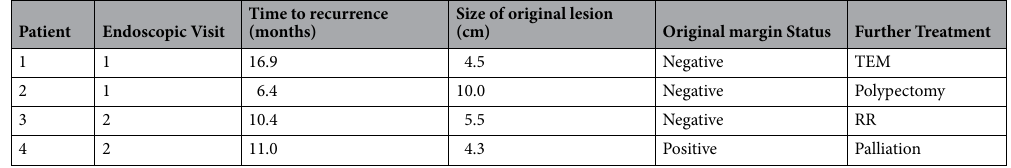
Table 4. Summary of Adenoma recurrences.